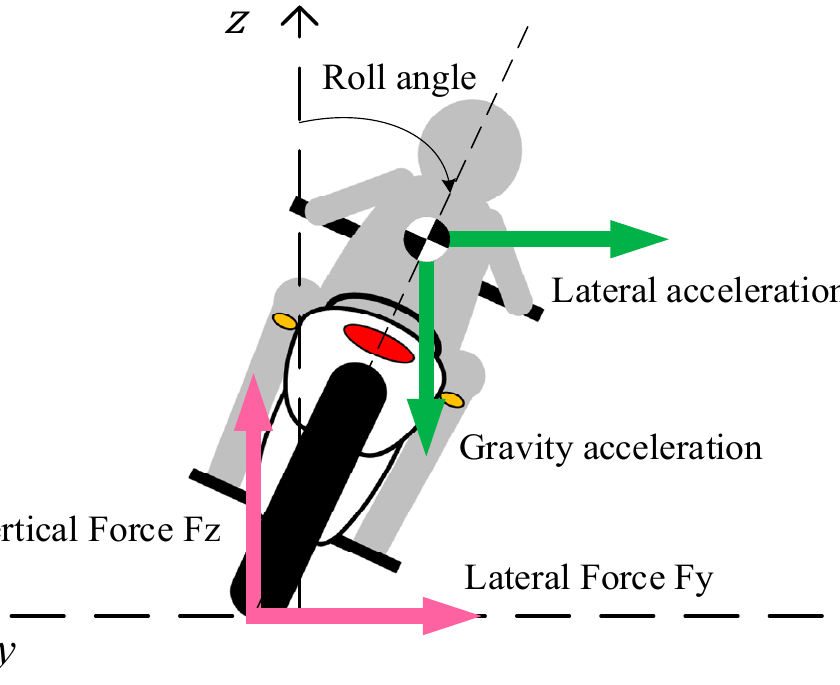
Figure 6. Force diagram for a motorcycle turning. When a motorcycle brakes during a turn, a lateral force and a longitudinal force act